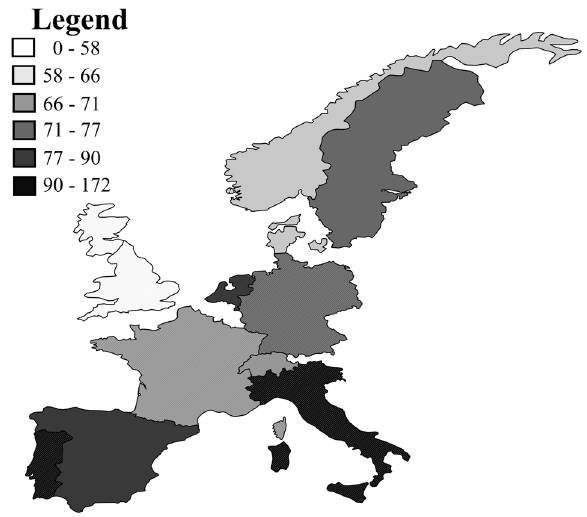
Fig. 2 Rates of excess deaths caused by the Spanish Flu from 1918 to 1919. Excess death rates are computed as the number of excess deaths per expected deaths. Darker grays indicate higher excess deaths. The countries shaded diagonally participated in